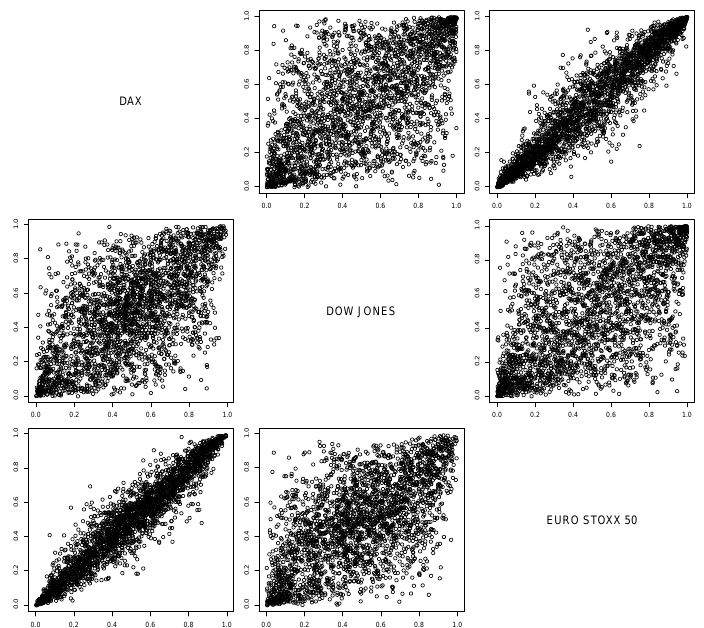
Figure 7: Pairwise scatter plots of the non-parametrically (above the diagonal) and parametrically (below the diagonal) trans- formed residuals of the ARMA-GARCH models for the DAX, Dow Jones and Euro Stoxx 50 indices.